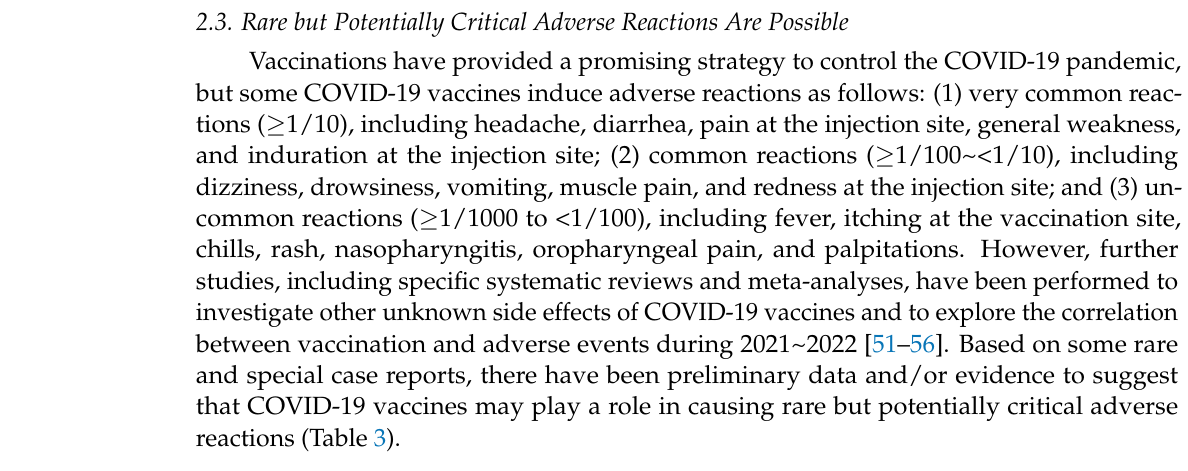
Table 3. Main COVID-19 vaccines and their rarely reported adverse